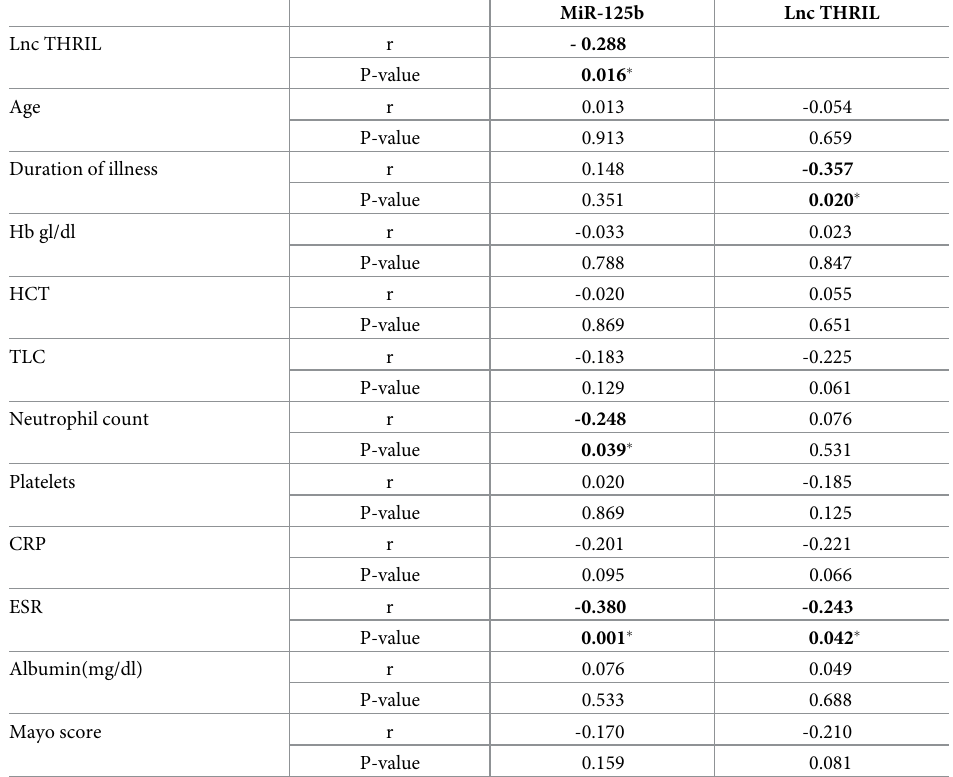
Table 5. Correlations of Lnc THRIL and MiR 125b with study parameters among UC